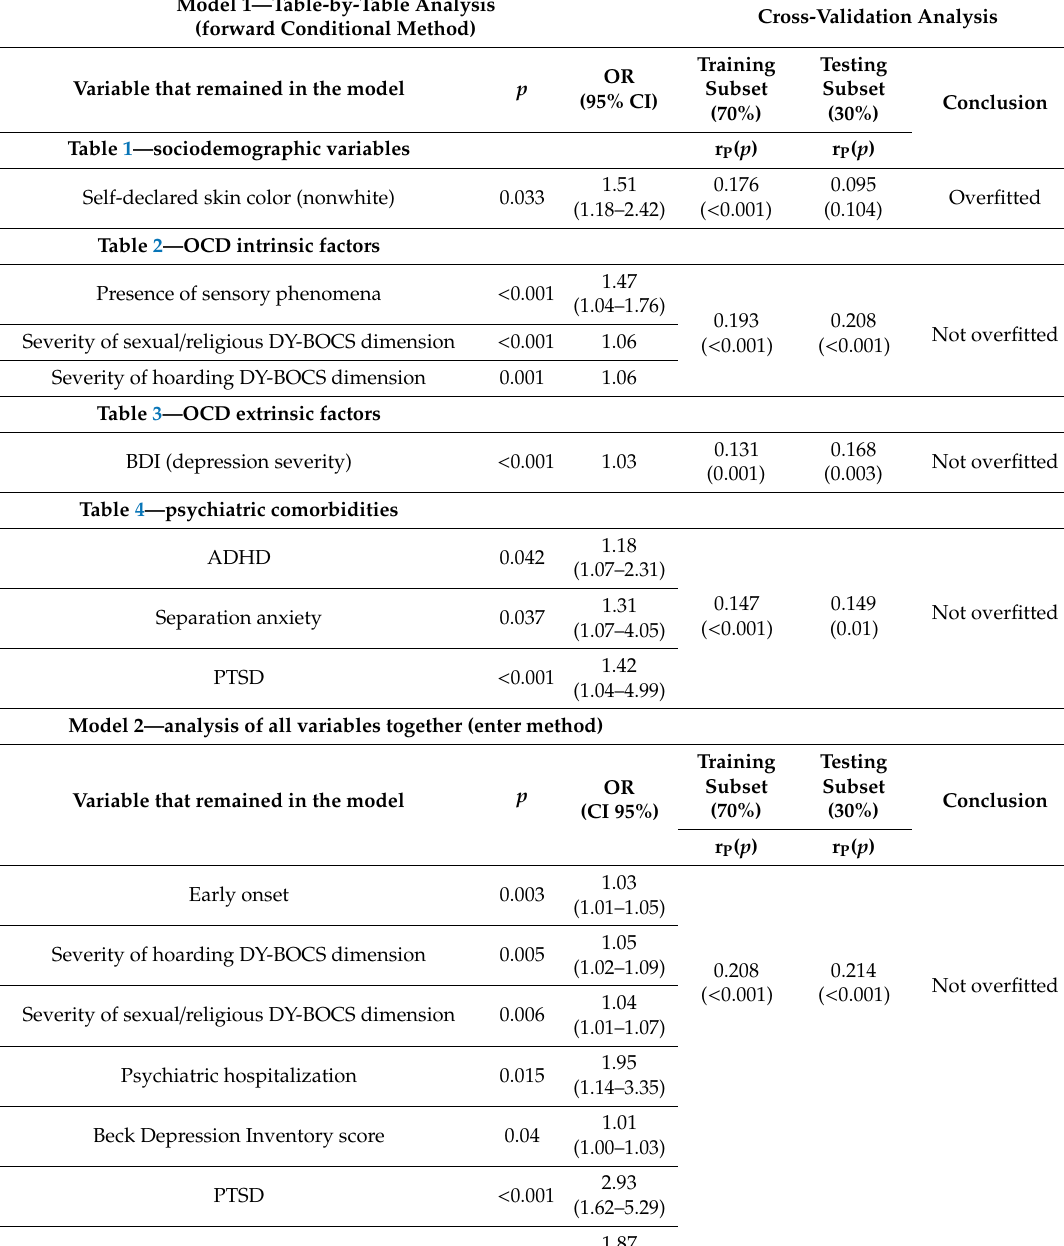
Table 5. Logistic regression models for the variables with p < 0.10 in the univariate analysis. Model 1—Table-by-Table Analysis (forward Conditional Method)